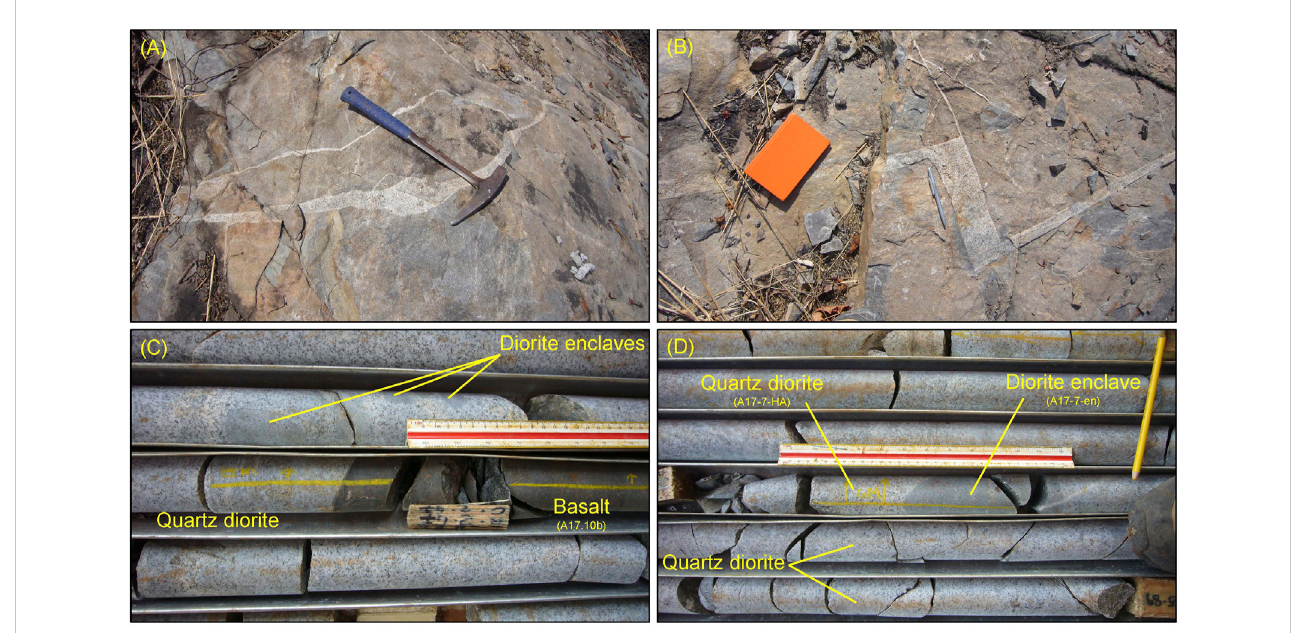
FIGURE 3 Field and drill hole photos of the Snoul pluton. (A, B) Fine to medium-grained diorite intruded by a coarse-grained dioritic dyke, demonstrating both (A) diffusive and (B) brittle,crack- fi lling fashionofdyking. (C, D) Diorite enclaves (irregular-torounded shape) andbasalts inaquartzdiorite hostrock intersected by drill hole A17 of the Snoul